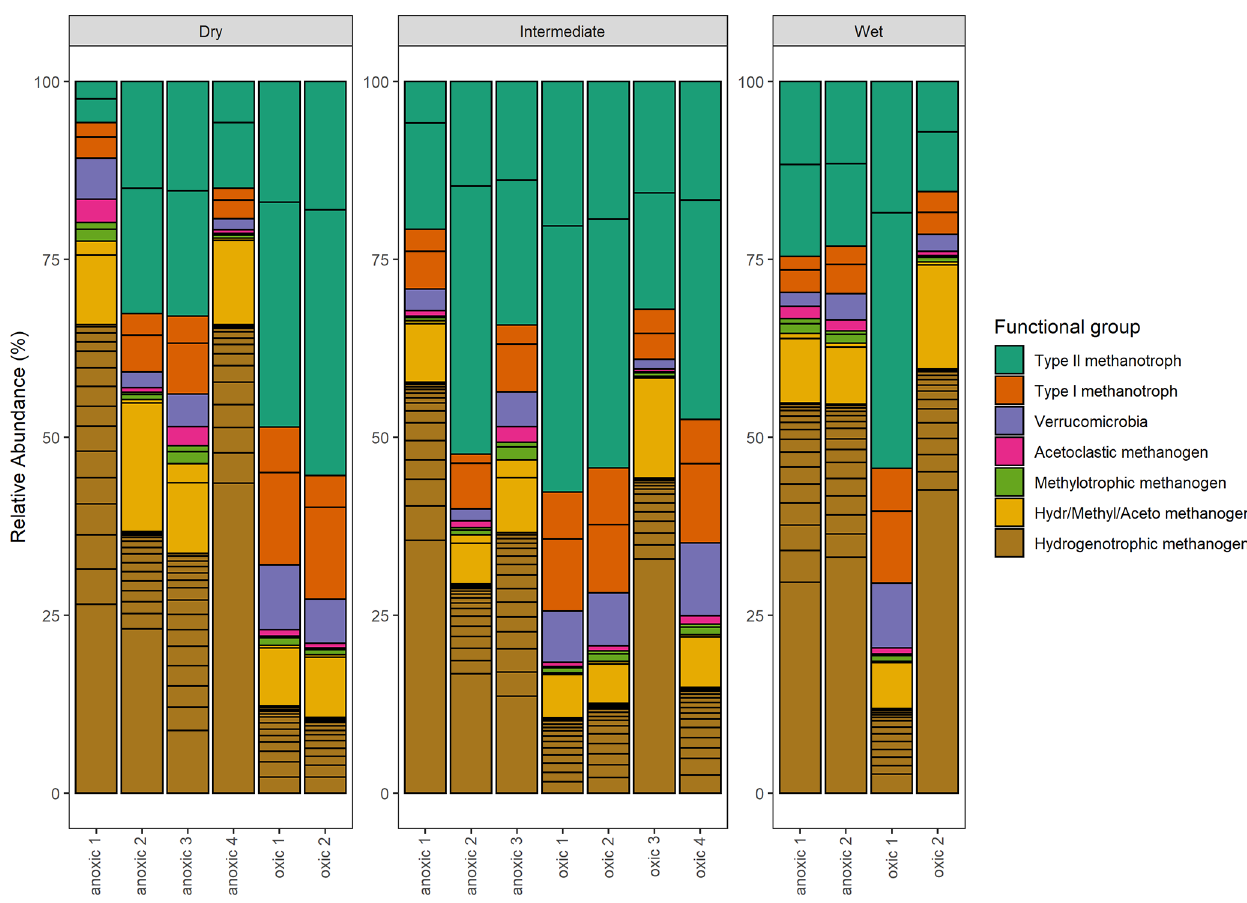
Figure 11. Taxonomic composition: the relative abundance (%) of methanogenic and methanotrophic microbes at the genus level. Color indicates the functional group and which metabolic pathway is utilized during